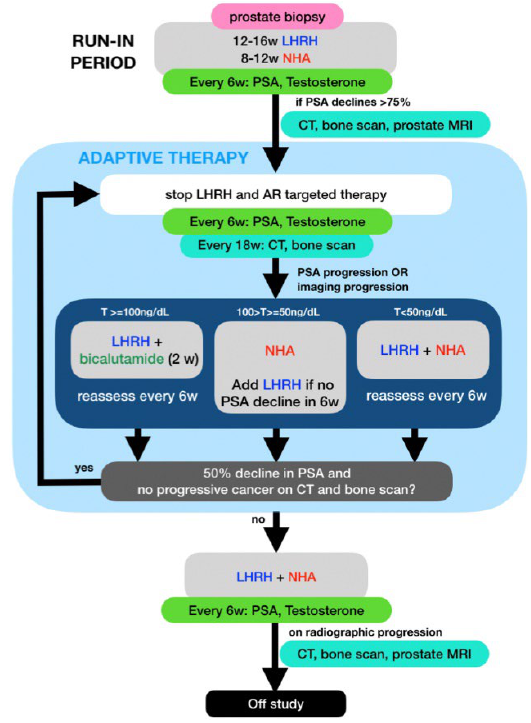
Figure 1. Schema for this mCSPC adaptive therapy trial showing selection of Luteinizing hormone- releasing hormone analog (LHRH) and or a new hormonal agents (NHA) based on PSA, total testosterone (T) and imaging.